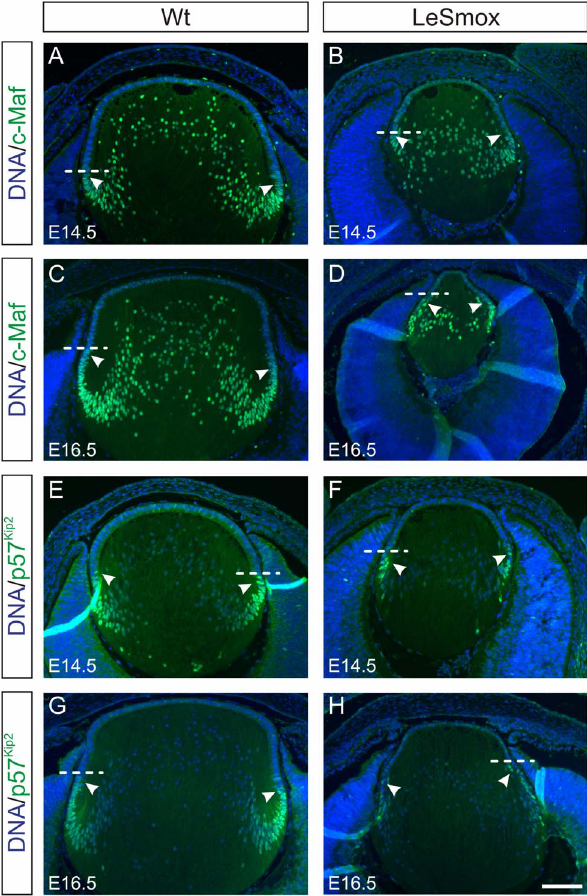
Figure 5. Expression of fibre cell markers in LeSmox lenses. Expression of c-Maf ( A–D ) and p57 Kip2 ( E–H ) proteins in Wt ( A, C, E, G ) and LeSmox ( B, D, F , H ) lenses at E14.5 ( A, B, E, F ) and at E16.5 ( C, D, G, H ). Reactivity for both c-Maf and p57 Kip2 proteins were detected in the nuclei of early differentiating fibre cells (arrowheads) below the lens equator (dashed line) in Wt and in LeSmox lenses in similar positions. Scale bar, A–H 100 m m.